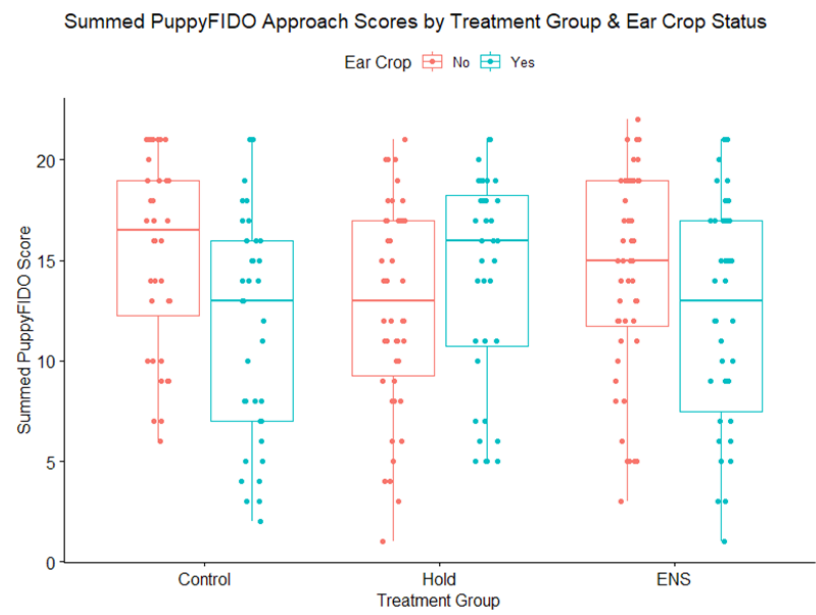
Figure 6. Summed scores for puppies from the PuppyFIDO test showing differences between the three treatment groups (control, held, and ENS) for puppies with cropped ears (Yes) and uncropped puppies (No). Higher scores represent more affiliative behaviors in response to stranger ’s approach.